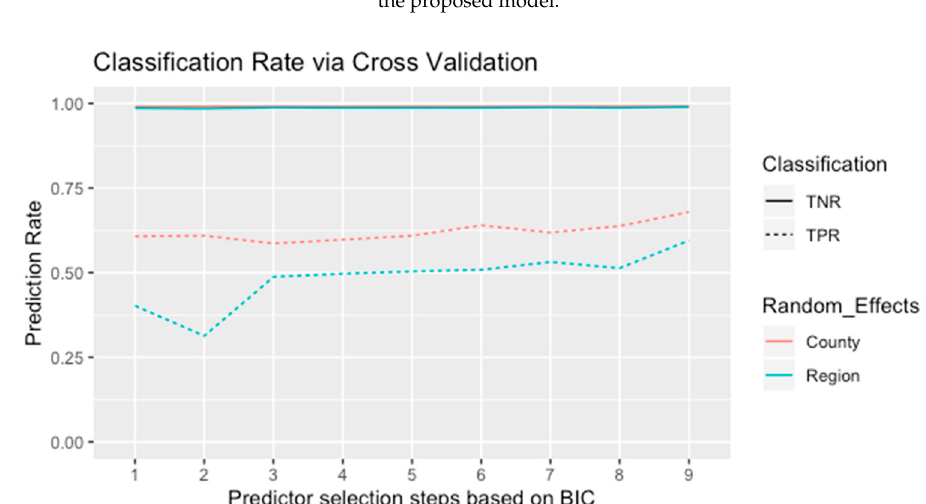
Figure 4. Cross-validation results for the validation data based on the model selection process shown in Table 5. Nine steps from the model with one predictor (average wind speed in June) to the proposed GLMMs with seven predictors. Solid lines are for true negative and dashed lines for true positive. Cyan and red lines represent the random effects based on county and region, respectively. Table 6. Estimation results for fixed effects and random effects by the generalized linear mixed model with the logistic link function. Model 1 stands for the GLMM with county random effect; model 2 stands for the GLMM with regional random effect.